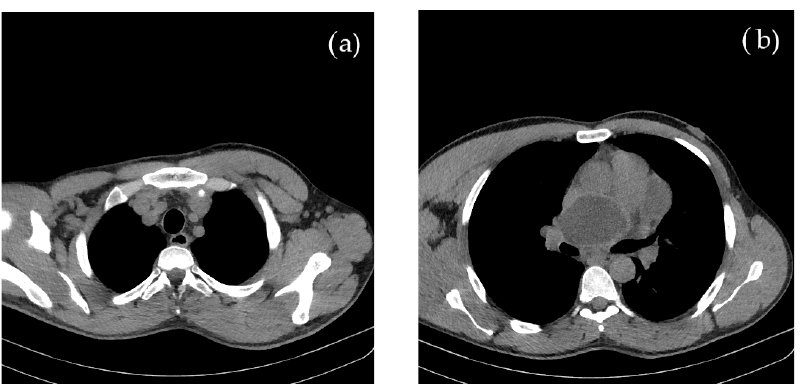
Figure 2. Contrast and native CT of thorax and abdomen shows multiple ( a ) mediastinal and ( b )